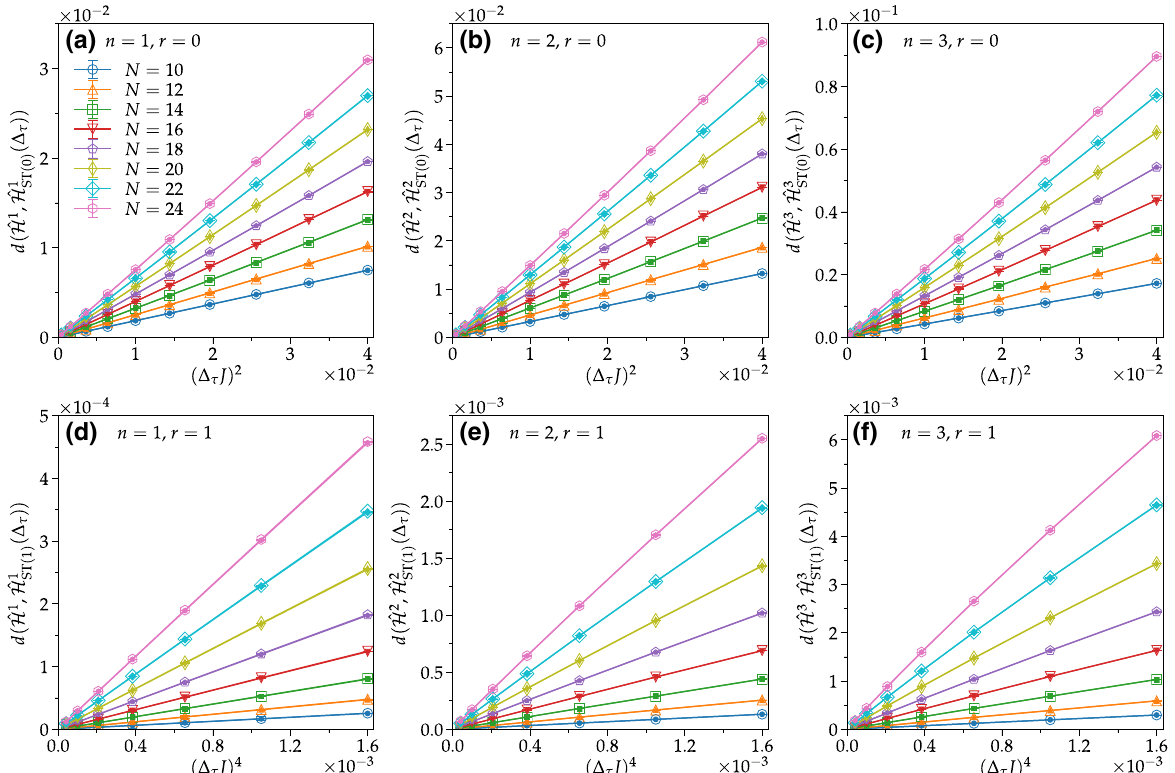
FIG. 3. (a)–(c) Distance